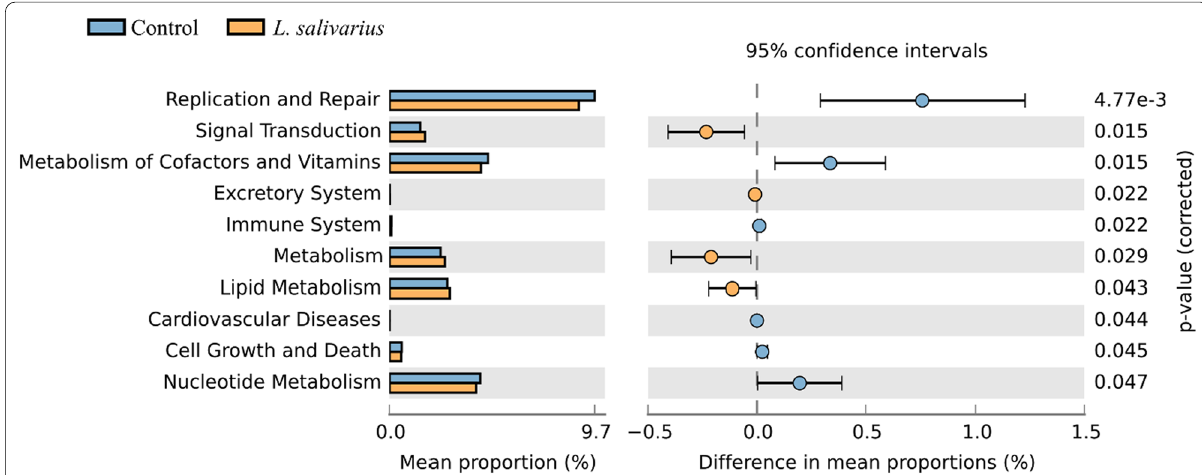
Fig. 4 KEGG pathways predicted in the gut microbiota of the control and heat-killed L. salivarius groups using PICRUSt.Statistical analysis was carried out using STAMP